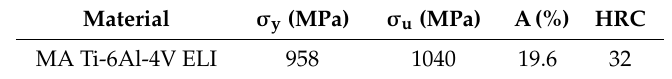
Table 2. Monotonic quasi-static tension properties of mill annealed (MA) Ti-6Al-4V ELI alloy.